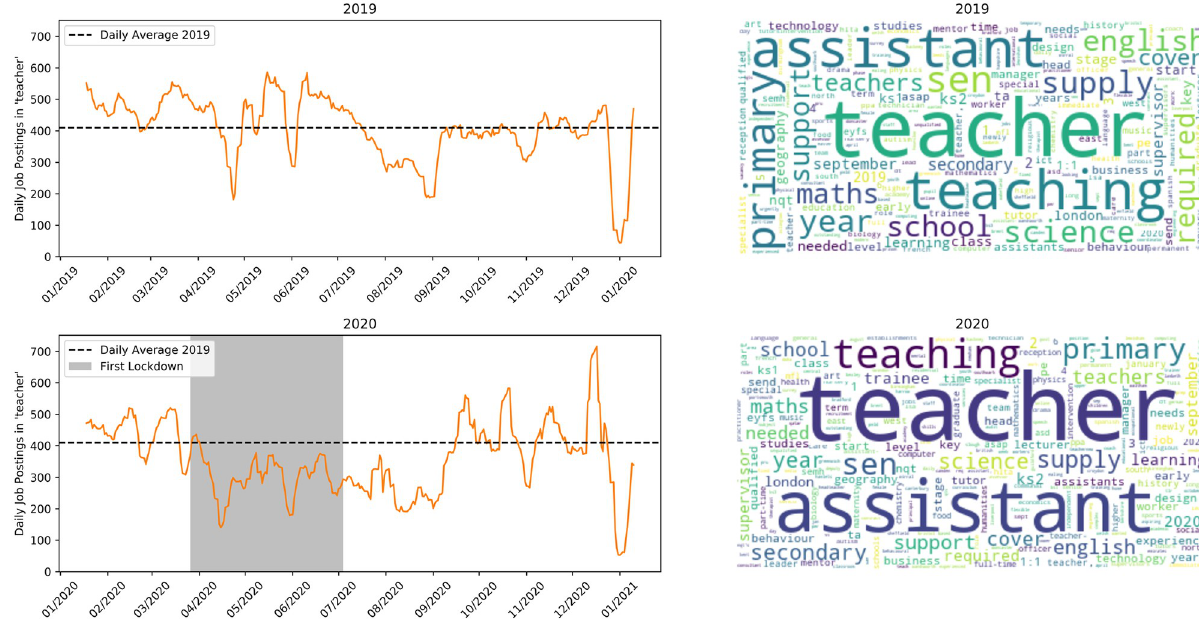
Fig 8. Jobs matching ‘teacher’. Top row is 2019, bottom is 2020.